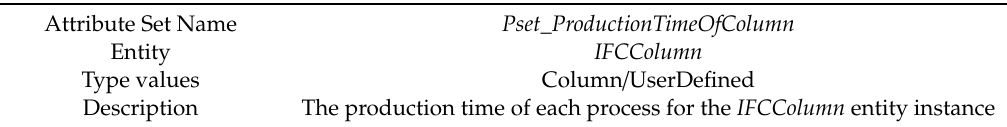
Table 4. The definition of Pset_ProductionTimeOfColumn.